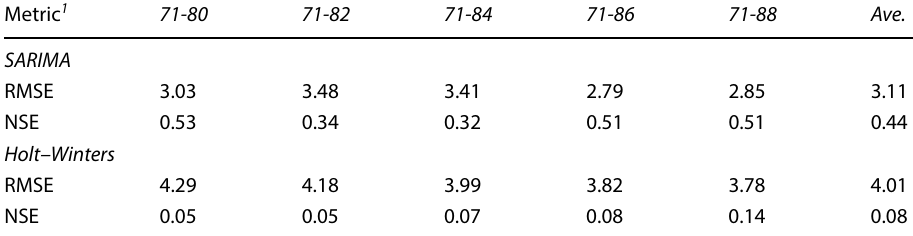
Table 2 SARIMA and HW training